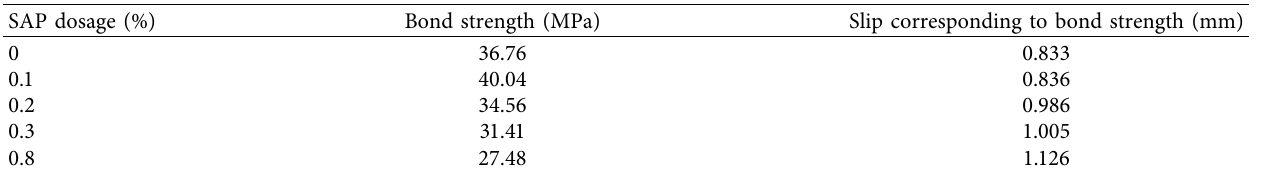
Table 4: Bonding strength of